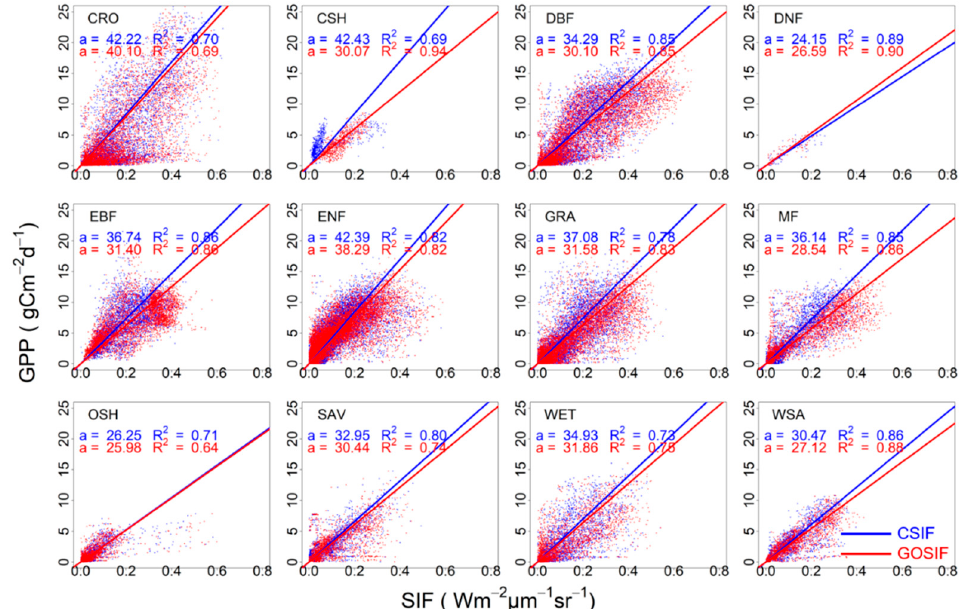
Figure 6. Scatter plots and linear regression of GPP and SIFc (CSIF and GOSIF) for 12 individual biomes at a daily scale ( p < 0.001). The statistical measures for the linear regression listed in the top left corner correspond to different colors. All the linear regressions were forced to go through the origin. The 12 biomes are similar to those in Figure 2.